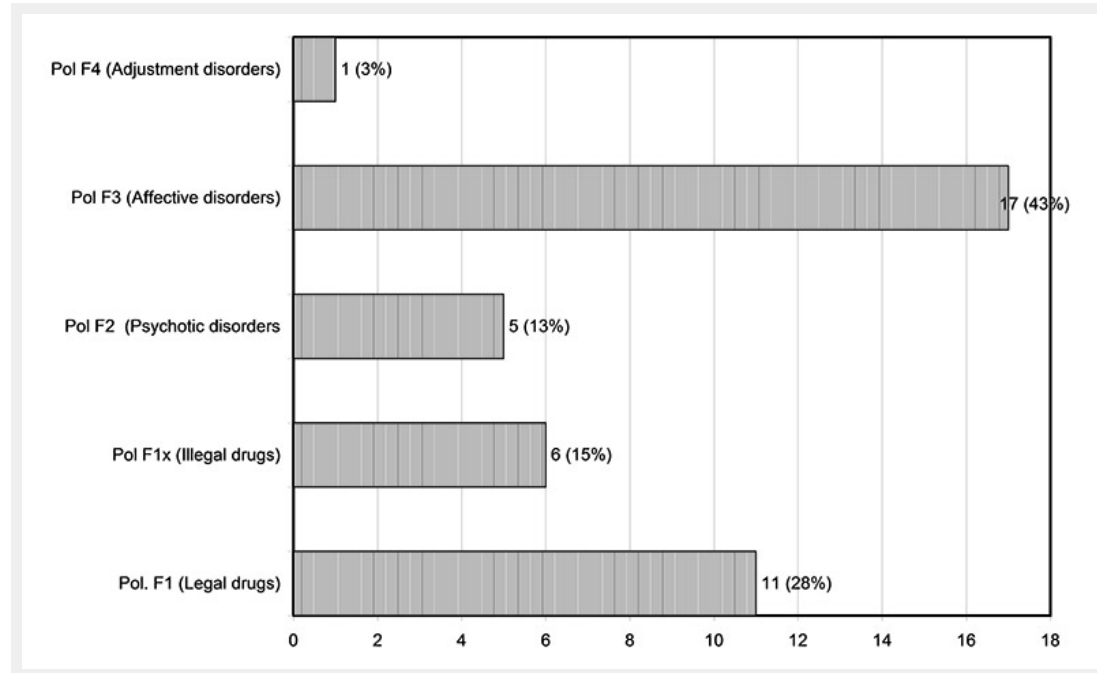
Figure 4 Psychiatric Diagnoses from Police Files (“police diagnosis”, n =